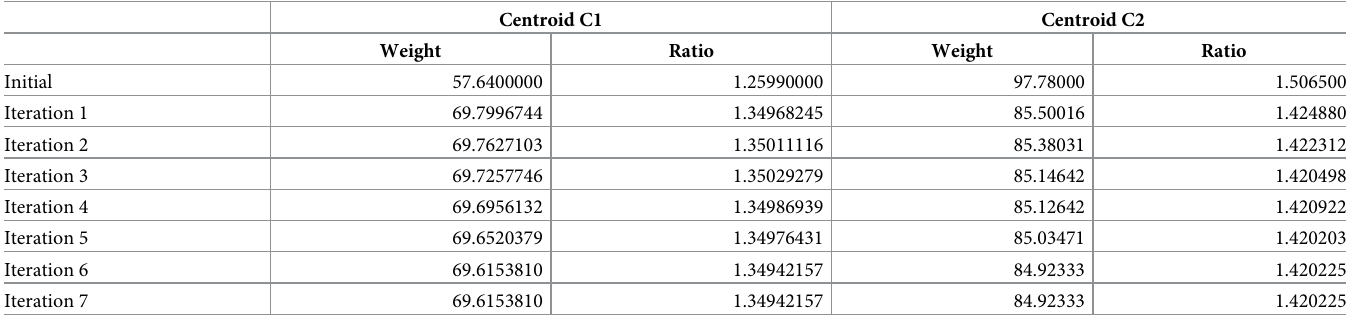
Table 1. K-means